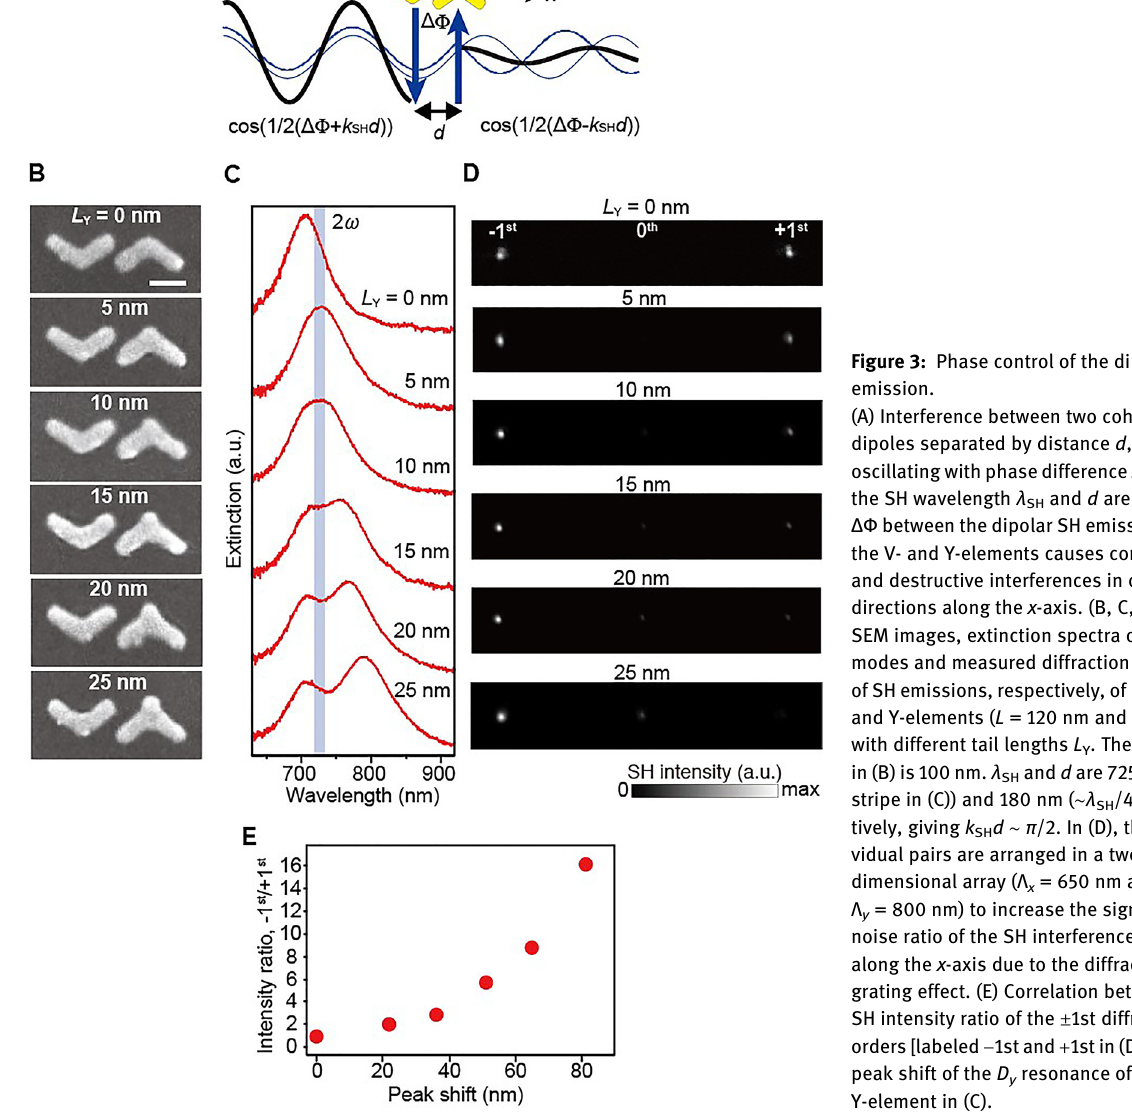
Figure 3: Phase control of the dipolar SH emission. (A) Interference between two coherent dipoles separated by distance d , oscillating with phase difference ΔΦ . When between the dipolar SH emissions from the V- and Y-elements causes constructive and destructive interferences in opposite directions along the x -axis. (B, C, and D) SEM images, extinction spectra of D y modes and measured diffraction